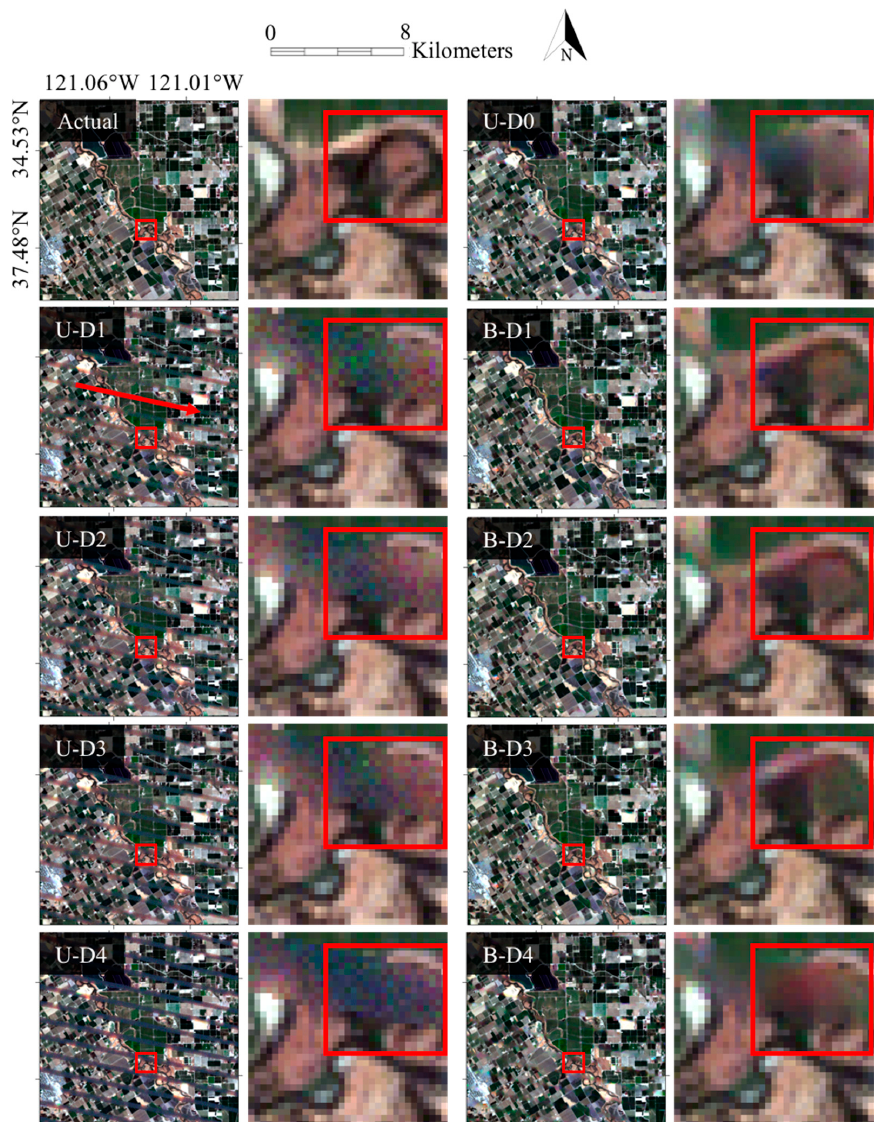
Figure 6. Mean realizations and the zoomed images for the nine test cases conducted over R3 (dense farmland). “Actual” is the actual image. “U-” and “B-” represents univariate and bivariate simulation. “D1”–“D4” represent the input images used for filling gaps, and “U-D0” is the univariate simulation without using an additional training image. The areas marked with red square in the mean realizations are magnified to the right of each pair. The location of the gap trace is denoted with an arrow in the mean realization of U-D1, and a red rectangular is marked in all zoomed images at the same location for the edge shape comparison in Section 3.2.